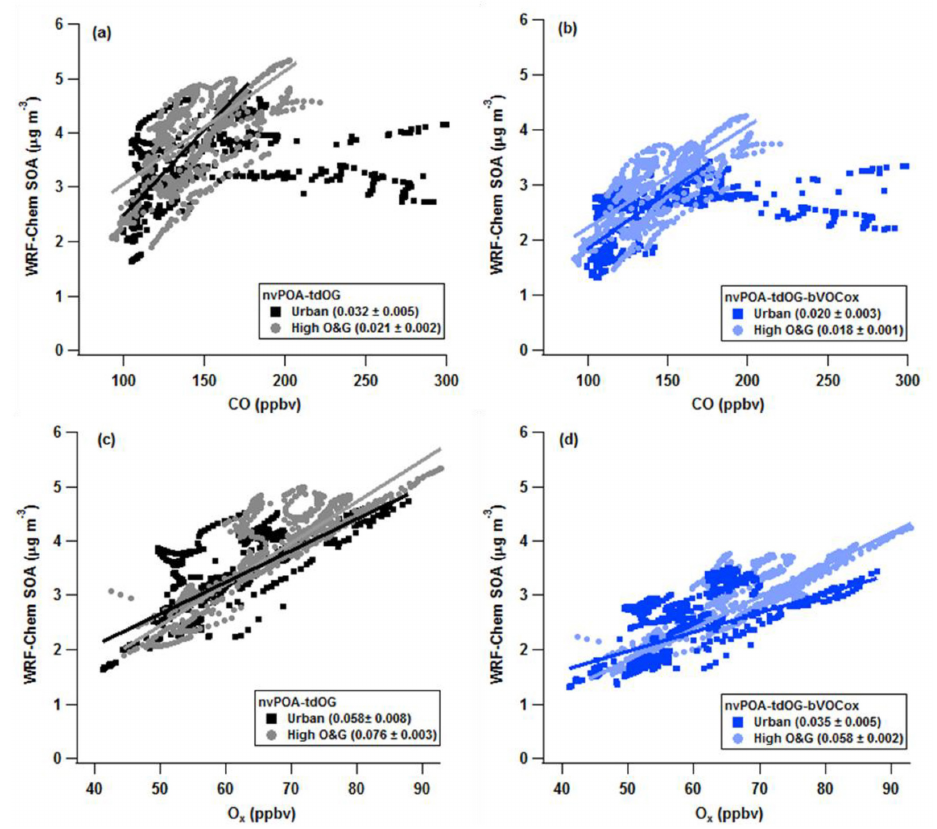
Figure 12. Correlation plots of predicted SOA against CO (a–b) and odd oxygen, O x , defined as O 3 + NO 2 (c–d) for model runs with non-volatile POA and top-down estimates of O&G emissions when biogenic SOA aging was turned on ( a and c ) and off ( b and d ). ODR slope values indicated in parenthesis are obtained considering data when simulated NO x / NO y <